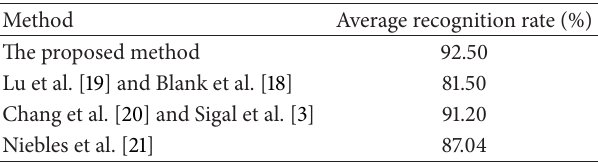
Figure 7: Confusion matrix for HumanEva data set. Table 1: Compared with other approaches on KTH dataset.